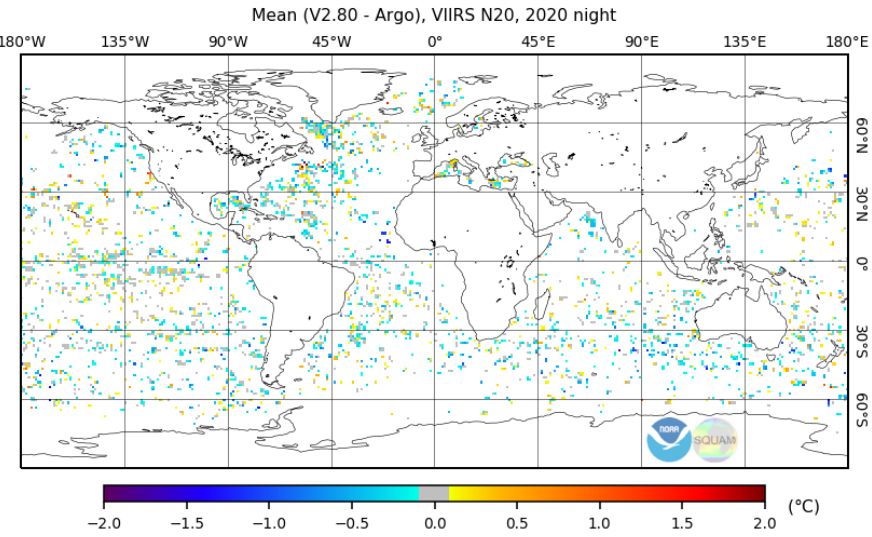
Figure 9. Aggregated for year 2020 maps of nighttime N20 VIIRS ‘subskin’ - AF SST. The figure is from the NOAA SST Quality Monitor (SQUAM) online system [18].